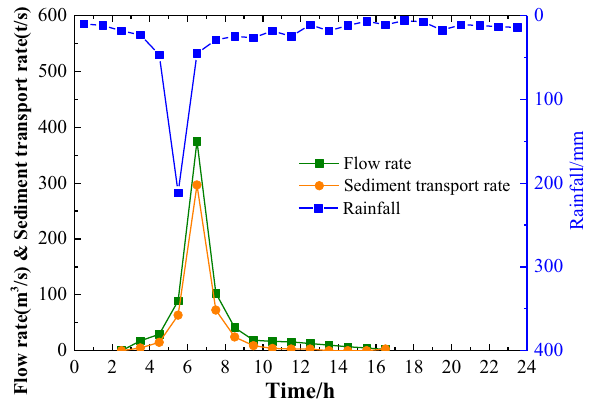
Figure 7. Water–sand relationship in the Loess Plateau